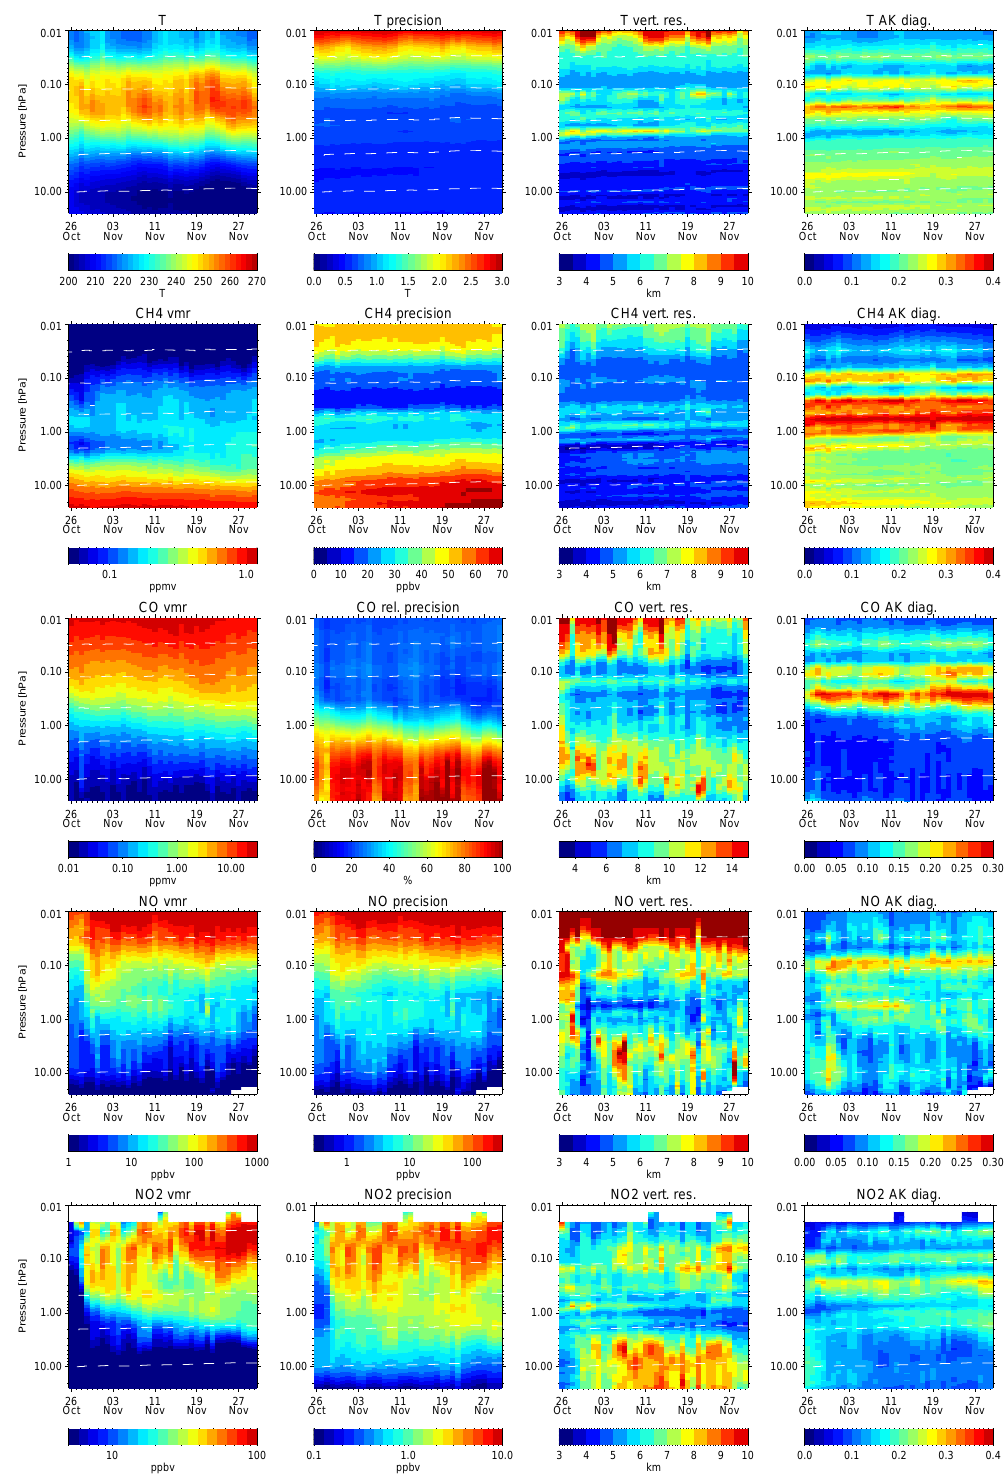
Fig. 1. Temporal evolution of MIPAS temperature, CH 4 , CO, NO, NO 2 , (from top to bottom) volume mixing ratio, single measurement precision, vertical resolution, and AK diagonal element profiles (left to right) during 26 October–30 November 2003 averaged over 60– 90 ◦ N. White dashed lines indicate 30, 40, 50, 60, and 70km geometric altitude levels. White regions reflect meaningless data (AK diagonal elements smaller than 0.03).